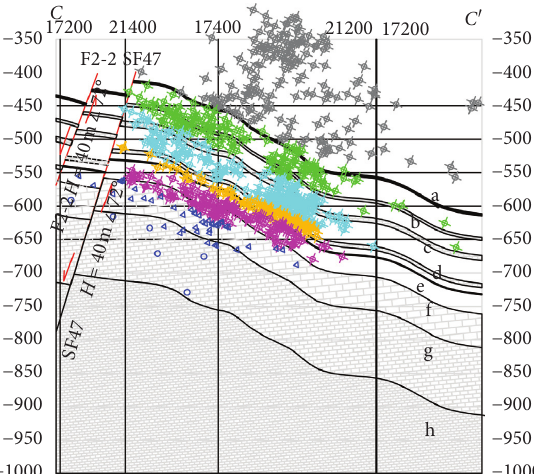
Figure 13: Distribution profile of microseismic events in April. a: 2# coal seam; b: Yeqing limestone; c: Shanfuqing limestone; d: Daqing limestone; e: 9# coal seam; f: Ordovician limestone; g: Ordovician limestone (50m); h: Ordovician limestone (100m).